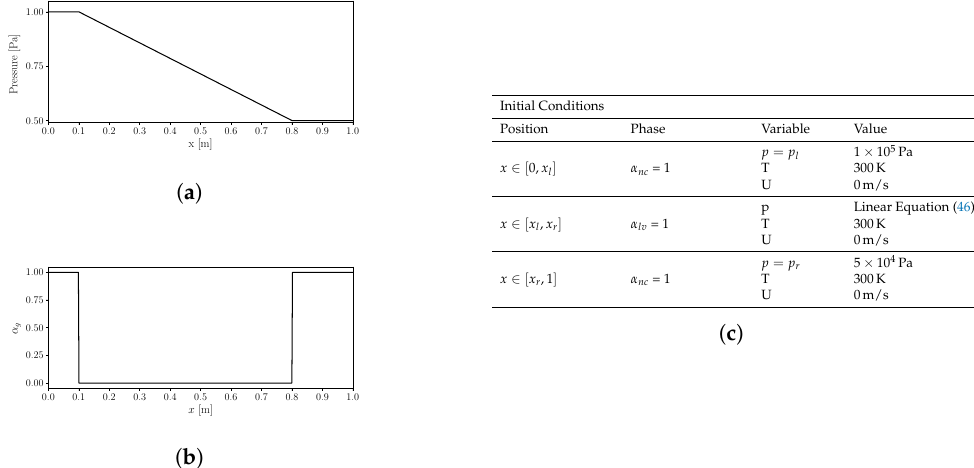
Figure 4. Oscillating water set-up, initial conditions: ( a ) pressure profile; ( b ) air distribution; ( c ) fluid